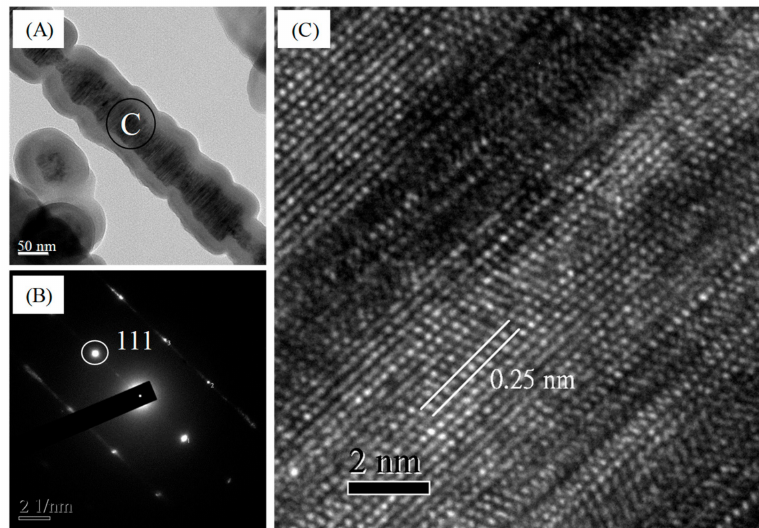
Figure 8. Transmission electron microscopy (TEM) image of a single β -SiC nanowire of sintered BcSiC prepared using five repeated cycles of sol–gel impregnation process ( A ), selected area electron di ff raction (SAED) pattern ( B ), and high-resolution transmission electron microscopy (HRTEM) image ( C ) obtained for the β -SiC nanowire.